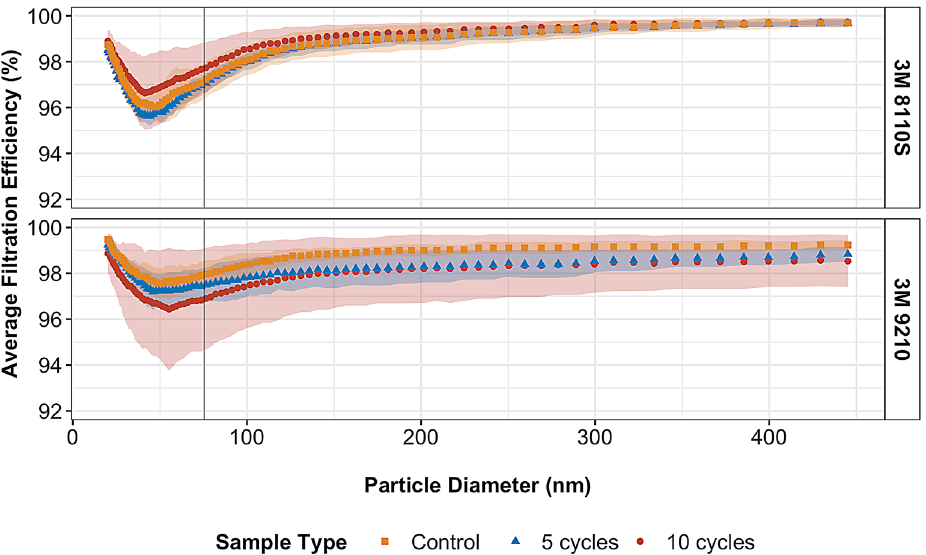
Figure 4. Filtration efficiency of airflow testing in 8110S and 9210 N95 respirators models compared to particle diameter. 75 nm count median diameter is noted by the dashed line. The shaded area represents standard deviation, n = 3. Software used: R studio, 1.3.959. Libraries: readxl, tidyverse, reshape2, ggthemes, ggsci,